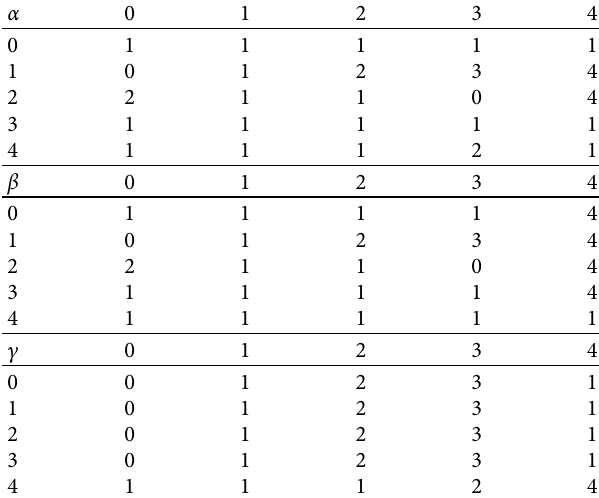
Table 14: Cayley tables for the binary operations “ α , β , and c